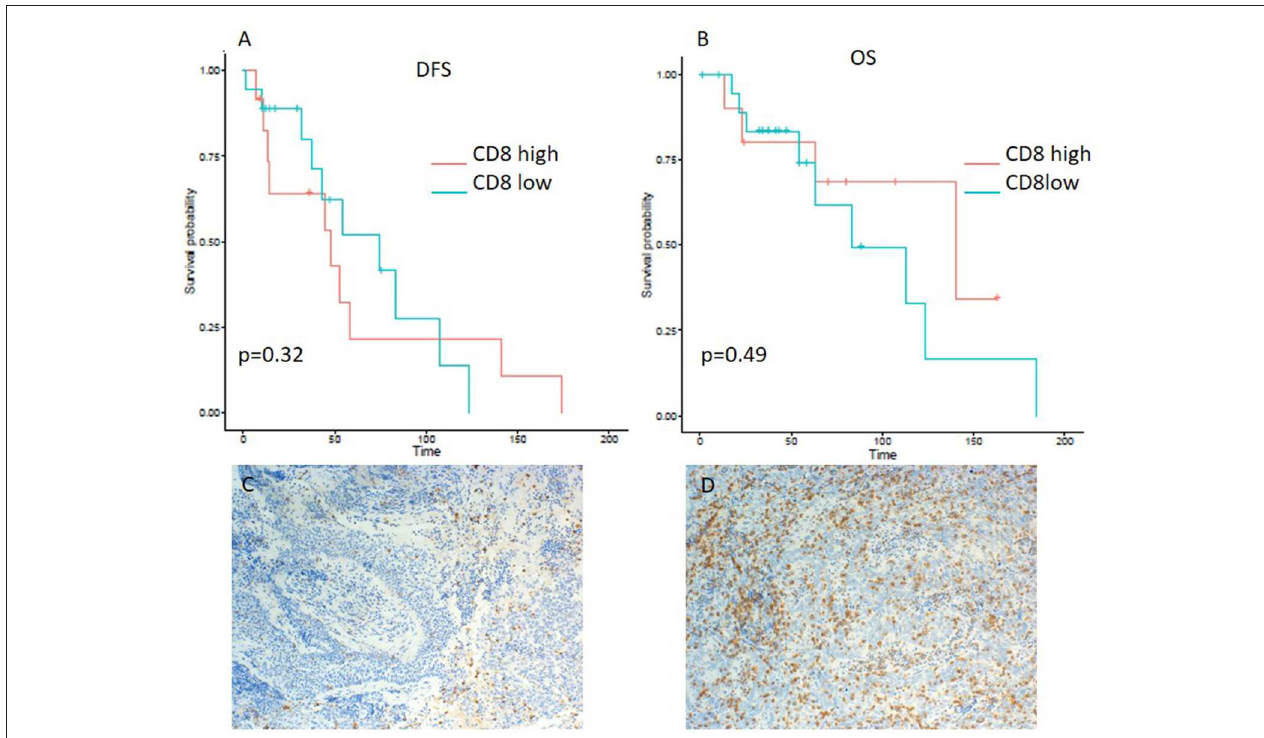
FIGURE 4 | Kaplan–Meier curves for DFS (A) and OS (B) according to CD8 expression on tumor infiltrating lymphocytes (TILs) (low vs. high). Representative images of CD8 expression on TILs: (C) low and (D) high (x100 magnification). Log-rank tests were performed, and p -values are depicted.